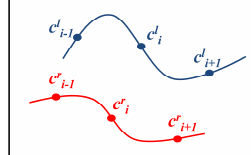
Figure 4. Example of intrinsic curves to measure local curvature similarity for occlusion detection